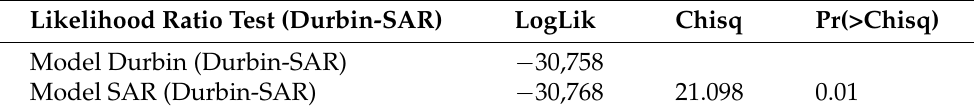
Table 5. Likelihood ratio